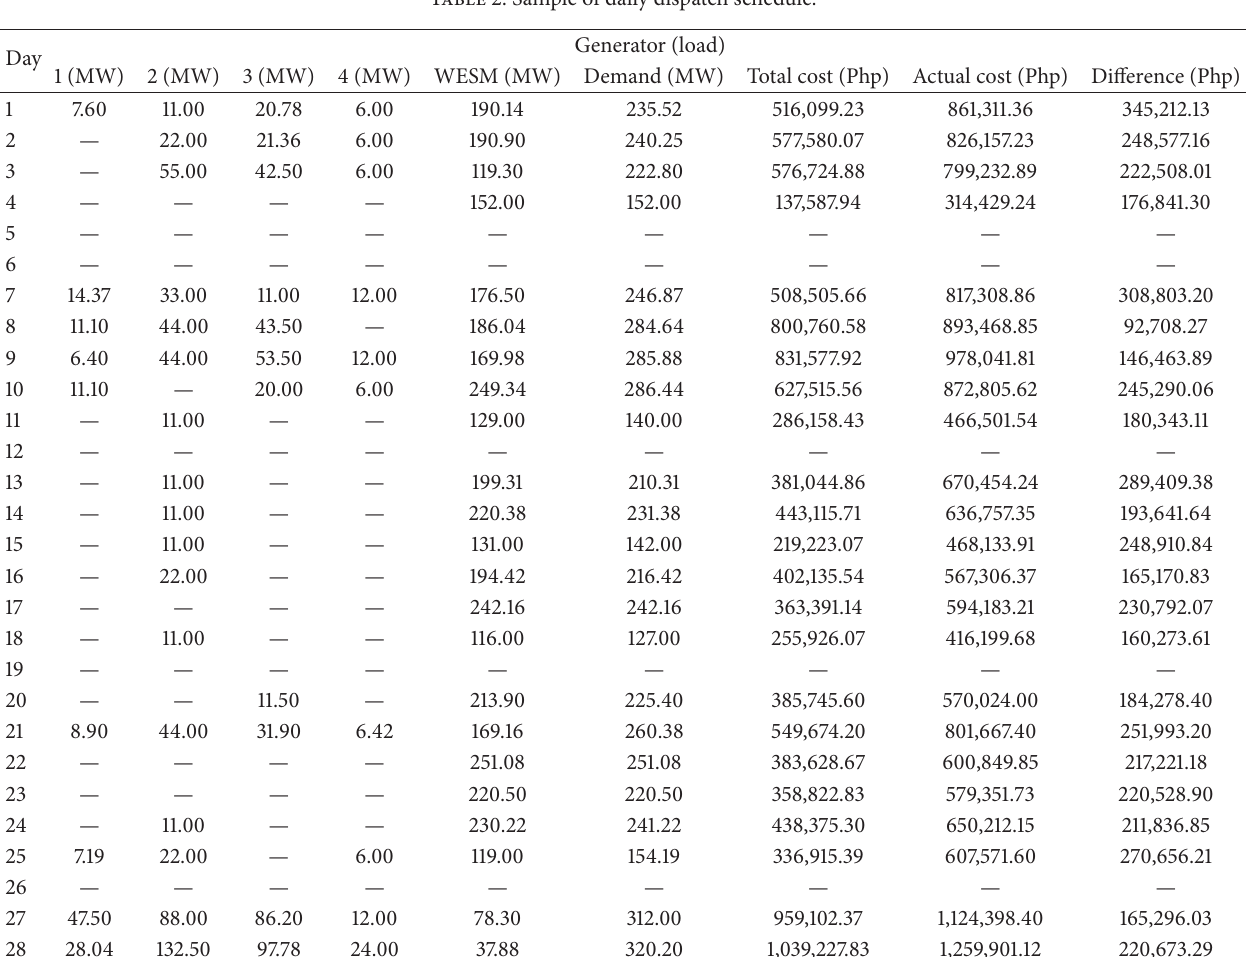
Table 2: Sample of daily dispatch schedule.